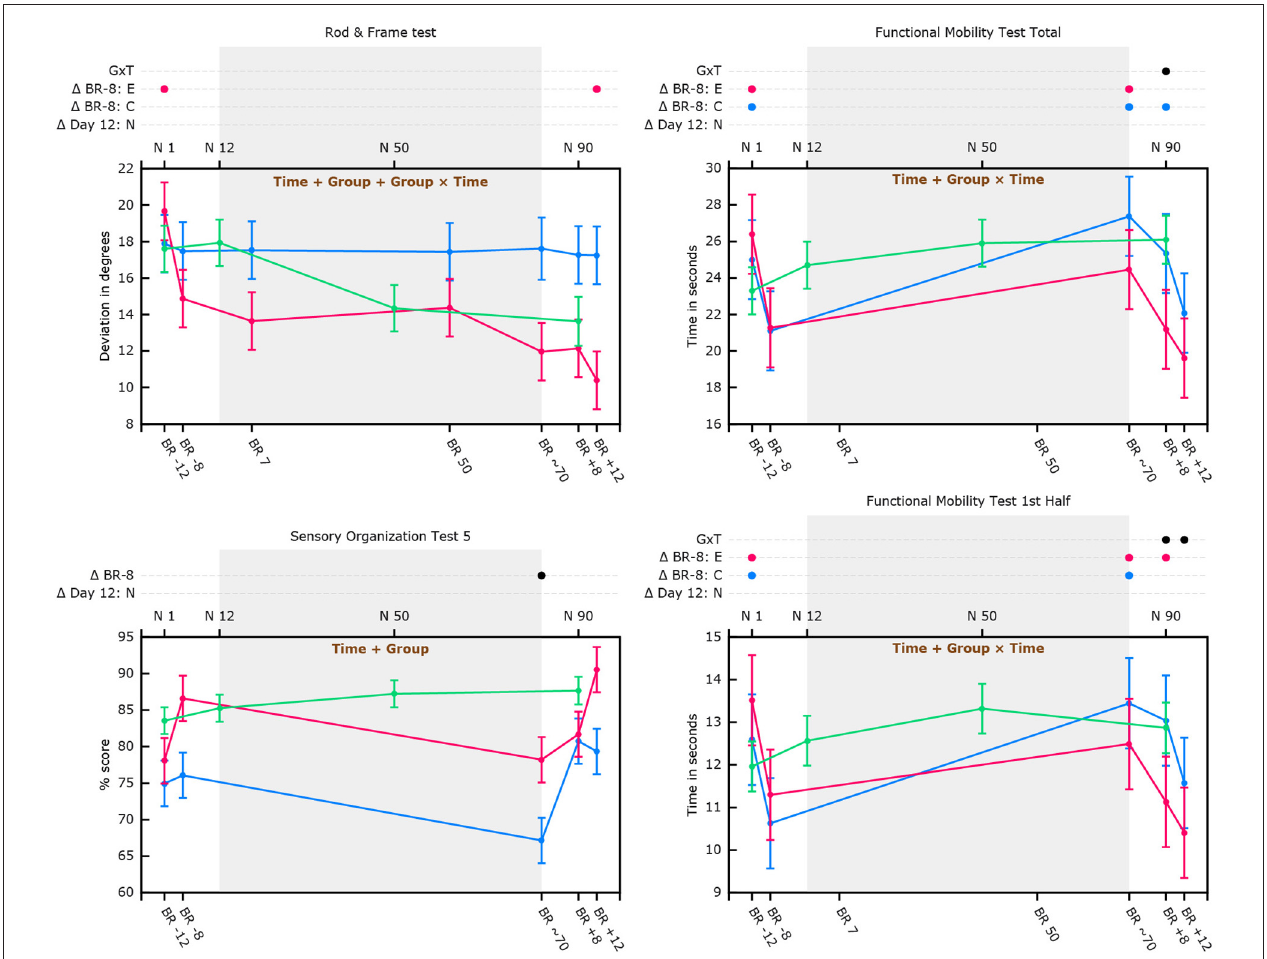
graphs show which main effects are significant for the HDBR analyses (e.g., time, time + group, or group + time + group × time). Dots (e.g., • ) indicate at which time point(s) values differ significantly from their baseline ( ∆ BR -8 = 8 days pre-HDBR for the total group of HDBR subjects; ∆ Day 12: N = day 12 for normative control subjects). In case of a significant group by time interaction effect or group effect of exercise separate lines are presented for HDBR control subjects (in blue; ∆ BR -8: C) and HDBR exercise subjects (in red; ∆ BR -8: E). ∆ G × T indicates time points with significant group by time